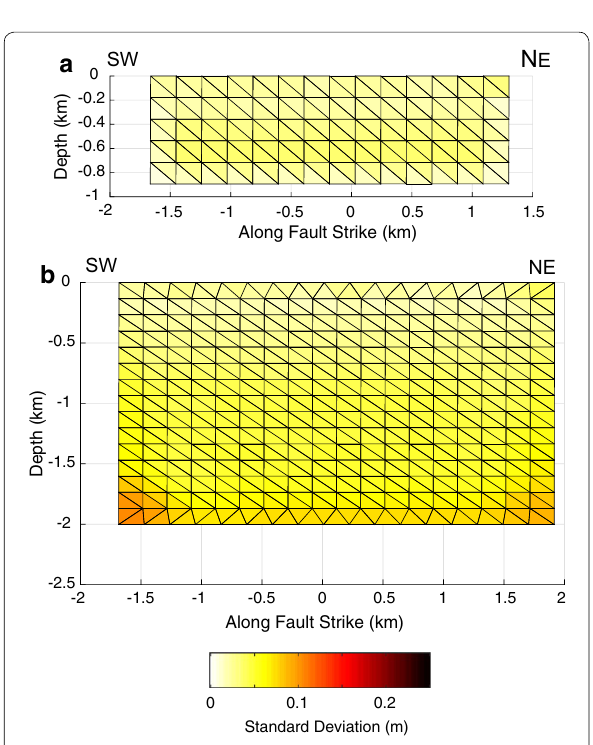
Fig. 9 Standard deviation of slip corresponding to the maximum likelihood fault model. a Northern fault. b Southern